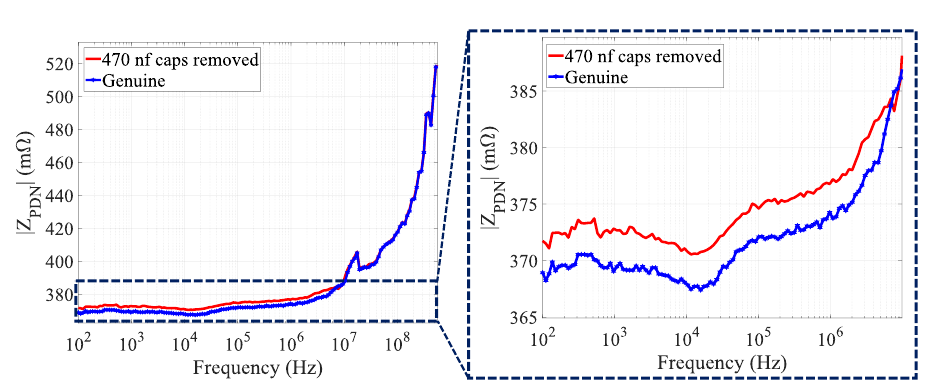
Figure 6: The mean of 105 impedance profile measurements for removing 470 nF decoupling capacitors over the frequency band of 100 Hz - 588 MHz. The right-side figure shows the zoomed-in view of the bandwidth with the most deviation from the mean